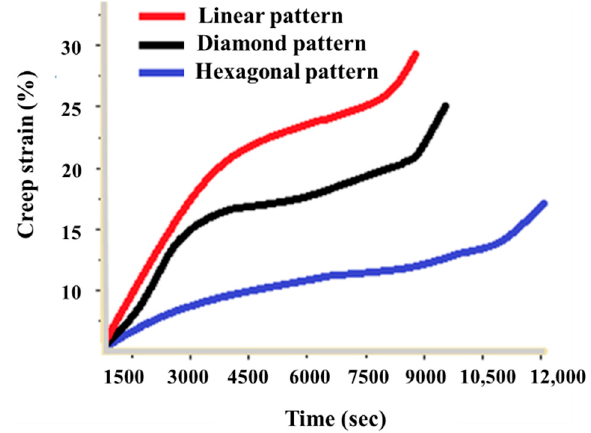
Figure 9. Time versus strain curve for creep testing specimens at di ff erent parametric setting.